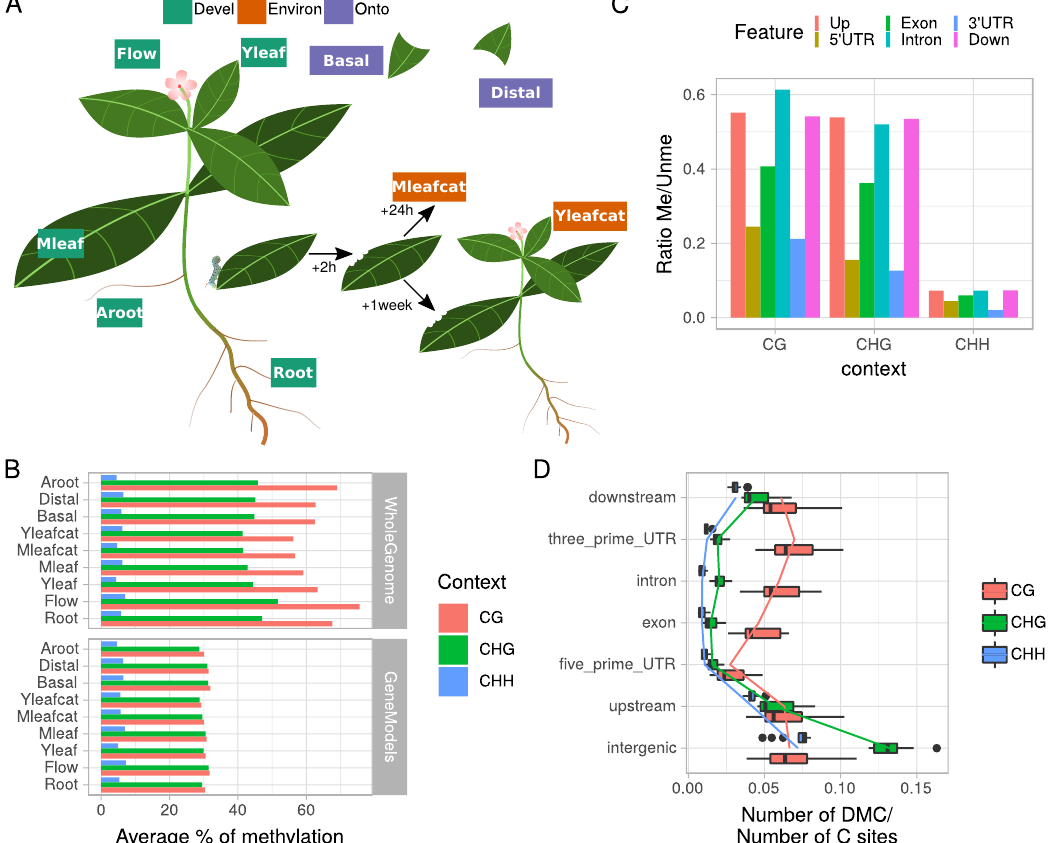
Figure 1. Overview of the C. roseus experimental design for the WGBS and methylome data . ( A ) Nine samples reflecting developmental variation within distinct organs (Leaf, Flower, Root or Adventitious Root) or during leaf ontogenesis (young versus mature; or basal versus distal) and environmental effects on leaf after direct (mature leaf 24h post folivory) or indirect (distance young leaf 1 week post folivory) biotic attacks were chosen to characterize whole genome cytosine methylation profiles. Flow = Flower; Aroot = Adventitious root; Mleaf = Mature leaf; Yleaf = Young leaf; Basal = Basal part of leaf; Distal = Distal part of leaf; Mleafcat = Mature leaf post folivory by caterpillars; Yleafcat = Young leaf from subjected plants 1 week after folivory on mature leaves. ( B ) Average % of cytosine methylation in the whole genome or gene model targeted approaches. ( C ) Average cytosine methylation levels of different gene features in each cytosine context for the whole genome approach ( D ) ratio between the number of differentially methylated cytosines (DMC) and number of cytosine sites per feature and cytosine contexts (CG, CHG, or CHH). In the whole genome approach, DMCs were retained if the difference in methylation between the two samples considered was